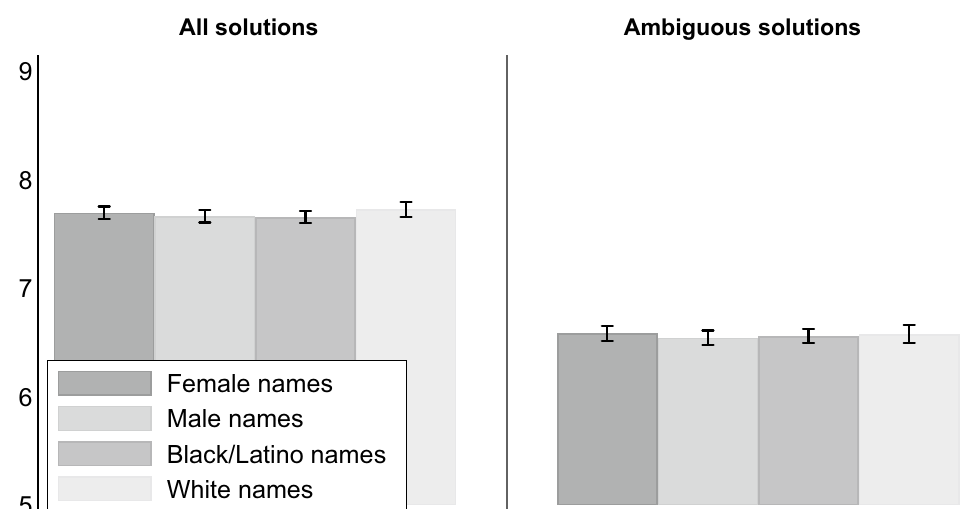
Fig. 2 Mean correctness score for student solutions by level of correctness, gender, and race of student names. Heteroskedastic‑robust standard errors clustered on teachers appear as bars around the mean estimates. Models also include controls for item and item positioning on the